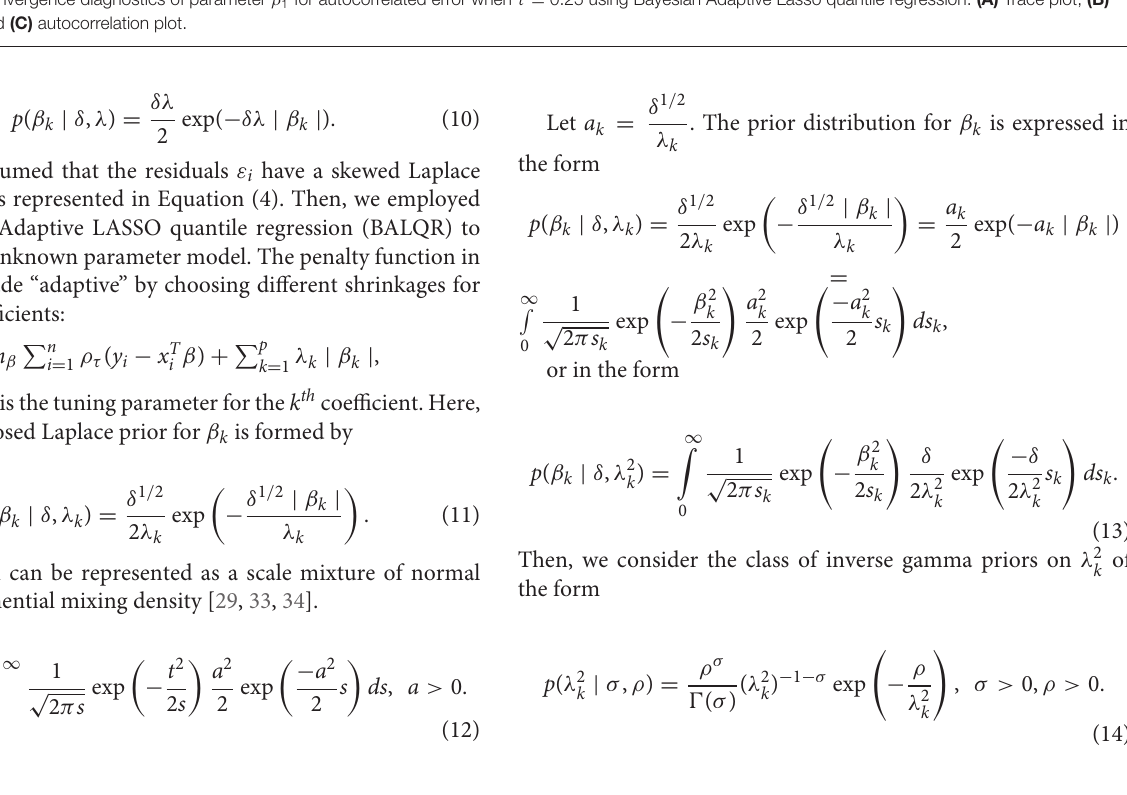
0.25 using Bayesian Adaptive Lasso quantile regression: (A) Trace plot, (B) =